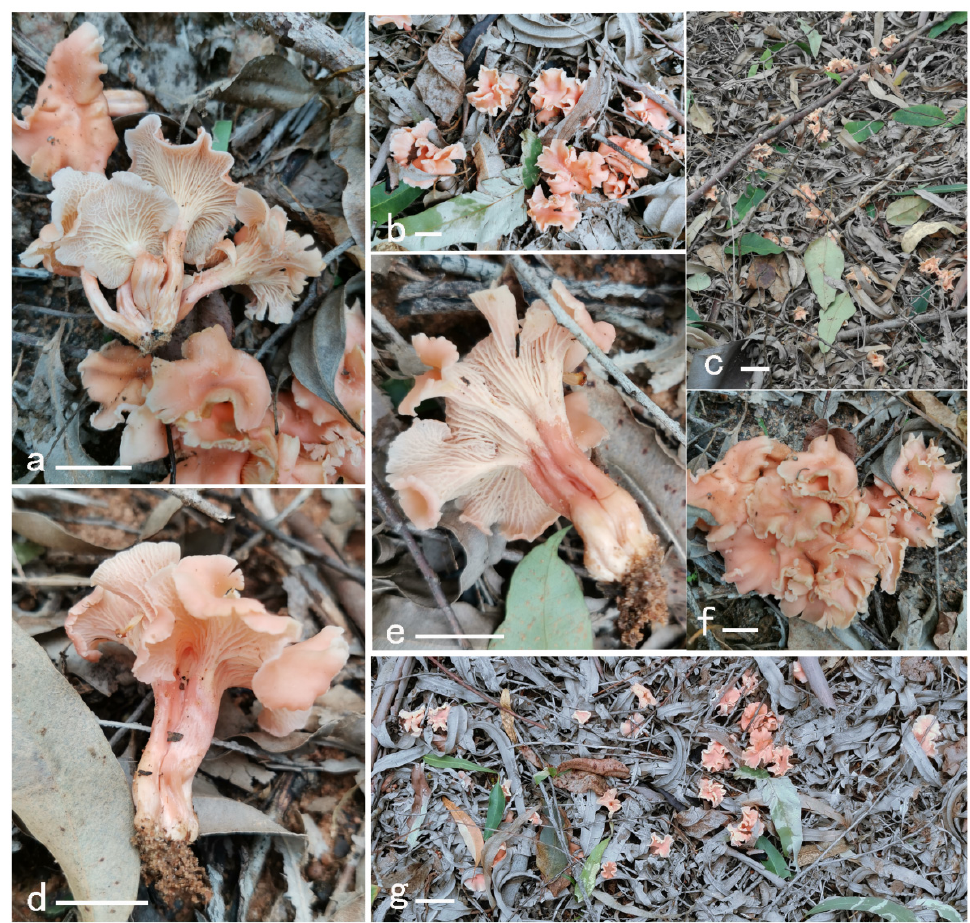
Figure 14. Basidiomata of Cantharellus neopersicinus . ( a – e ) GDGM87366. ( f , g ) GDGM85145. Bars: ( a , b , d – f ) = 2 cm; ( c , g ) = 5 cm.